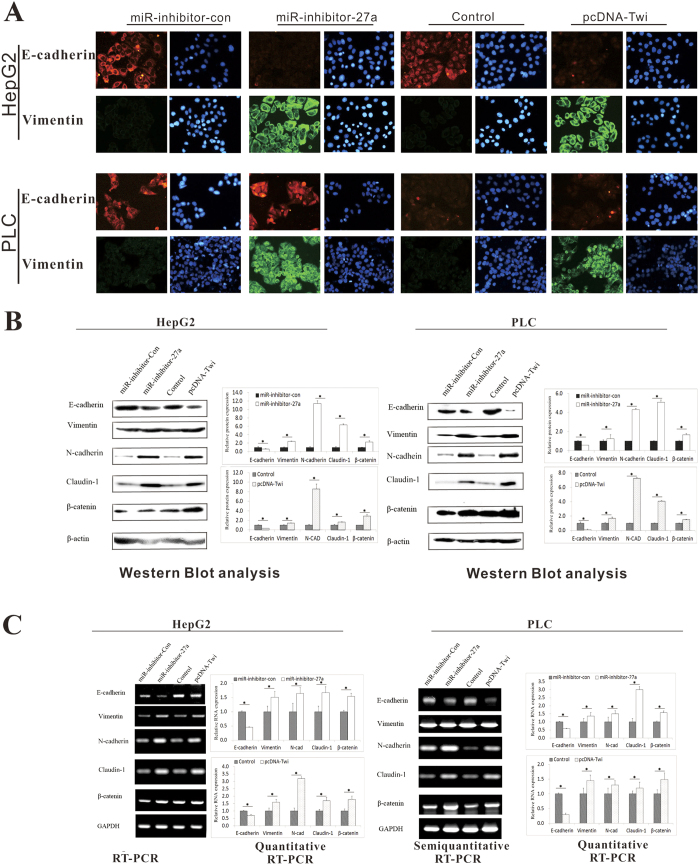
Down-regulation of miR-27a-3p induced EMT signaling.HepG2 and PLC cells were transfected with miArrest™ miRNA Inhibitor Expression Clone miR-27a-3p (miR-inhibitor-27a) or pcDNA3-Twist-1 (pcDNA-Twi). (A) The immunofluorescence results showed the expression of E–cadherin and vimentin in HepG2 and PLC cells. (B) Western blot showed the protein expression of E–cadherin, vimentin, N-cadherin, Claudin-1 and β-catenin in HepG2 and PLC cells. (C) Semi-quantitative and quantitative RT-PCR analyses showed the mRNA expression of E–cadherin, vimentin, N-cadherin, Claudin-1and β-catenin in HepG2 and PLC cells. In immunoblotting assay, gels have been run under the same experimental conditions. Then cropped blots were incubated with different primary antibodies for analysis of signaling pathway. Full-length blots are included in the (supplementary information Fig. S7)